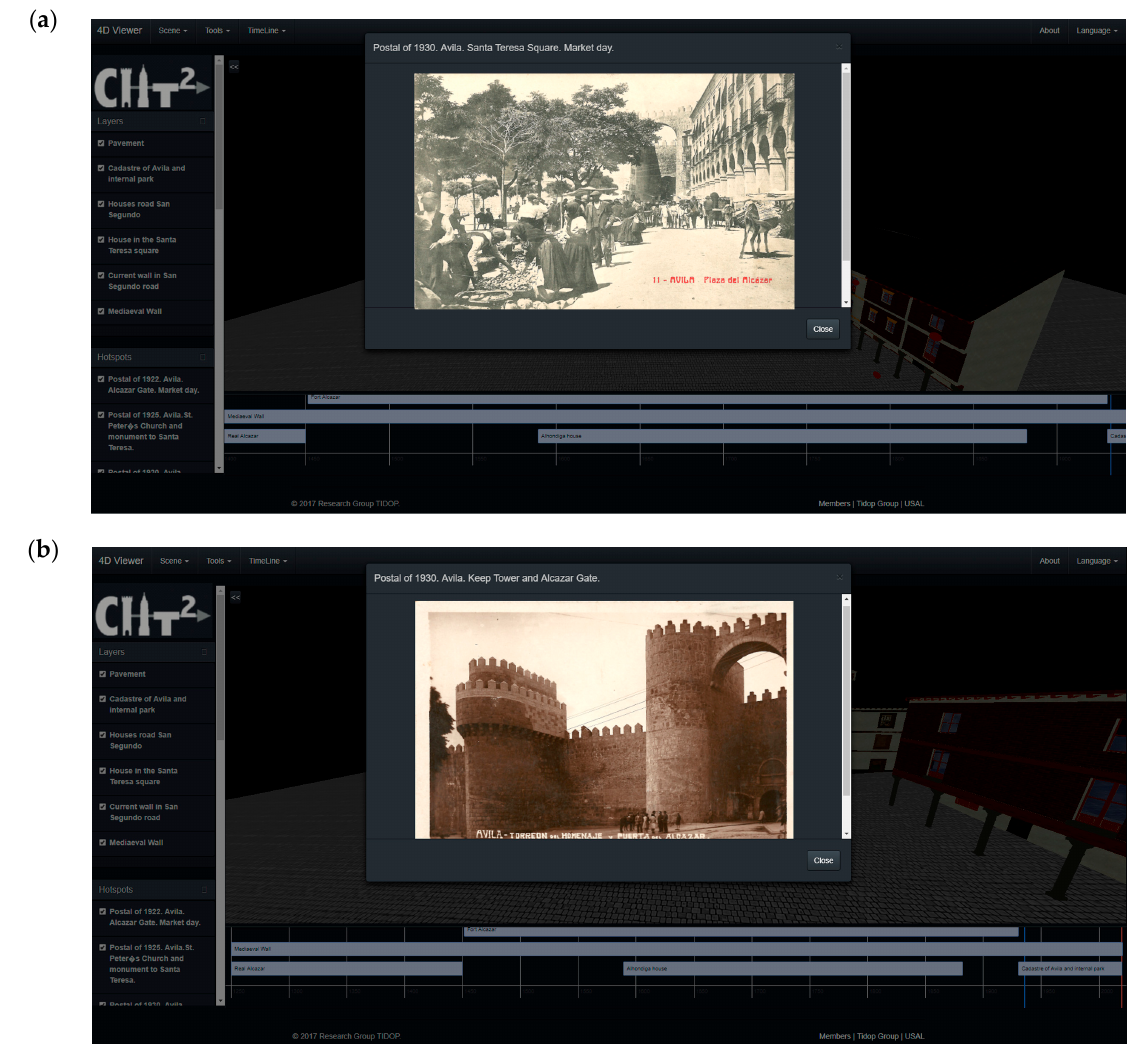
Figure 15. Examples of non-geometrical data included inside the modal windows: ( a ) an historical photograph taken during the market day in the Alcázar gate; and ( b ) a postal notice about the Alcázar gate printed in 1930. It is worth mentioning that the information that appears in both modal windows (hotspots) enhances the capacities of the viewer, allowing the transmission of intangible values ( a ) or even useful information for the study of the evolution of the restoration theories along with the history ( b ).